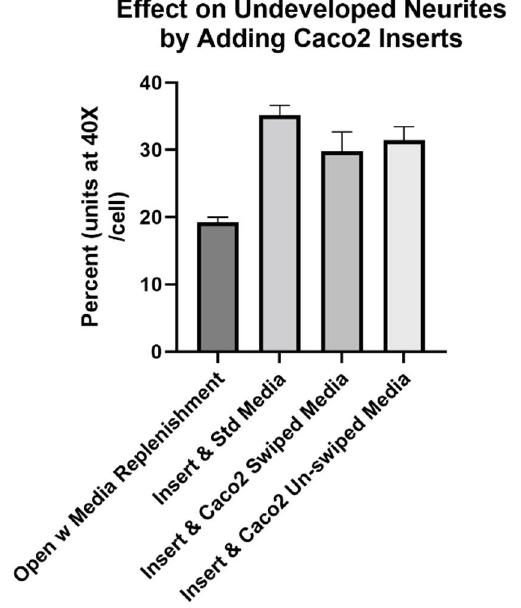
Figure 4. Caco2Bbe1 inserts, alone, induce higher percent of neurites in SH-SY5Y cells. SH-SY5Y’s were plated in open wells at low density ( n = 400/well) in complete (10% FBS) media. They received inserts on day 6. The experimental variable that occurred on day 6 was insert addition and/or the type of media under the inserts. Namely, from left to right, either: remained open wells but replenished with standard complete (10% FBS) media; added Caco2Bbe1 inserts at the same time as replenished basally with standard complete media; added Caco2Bbe1 inserts at the same time as replenished basally with complete conditioned media taken from confluent Caco2Bbe1 swiped 2 days earlier, or; added Caco2Bbe1 inserts at the same time as replenished basally with complete conditioned media taken from confluent Caco2Bbe1 cells which had not been swiped. Two days afterward, the media was removed, cells were washed and stained with crystal violet, and photographs were made using 40× phase contrast microscopy. Cells were traced and the average neurite area percent was computed using ImageJ software. Bars are means ± SEMs. All three experimental bars are significantly higher than media-only controls ( p < 0.01). The right three bars were not significantly different from each other.